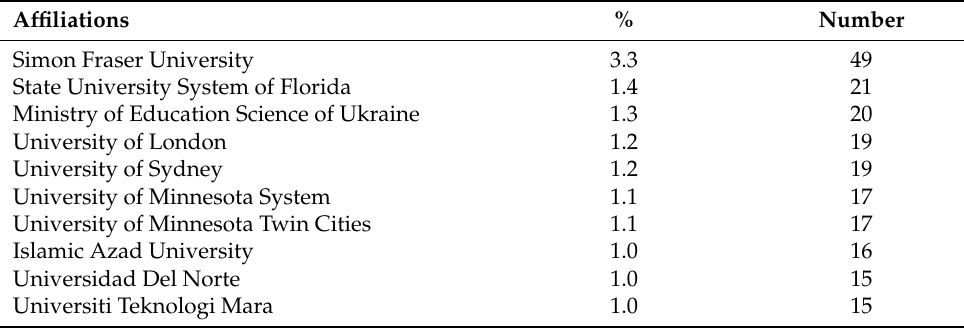
Table 8. Number of publications by research